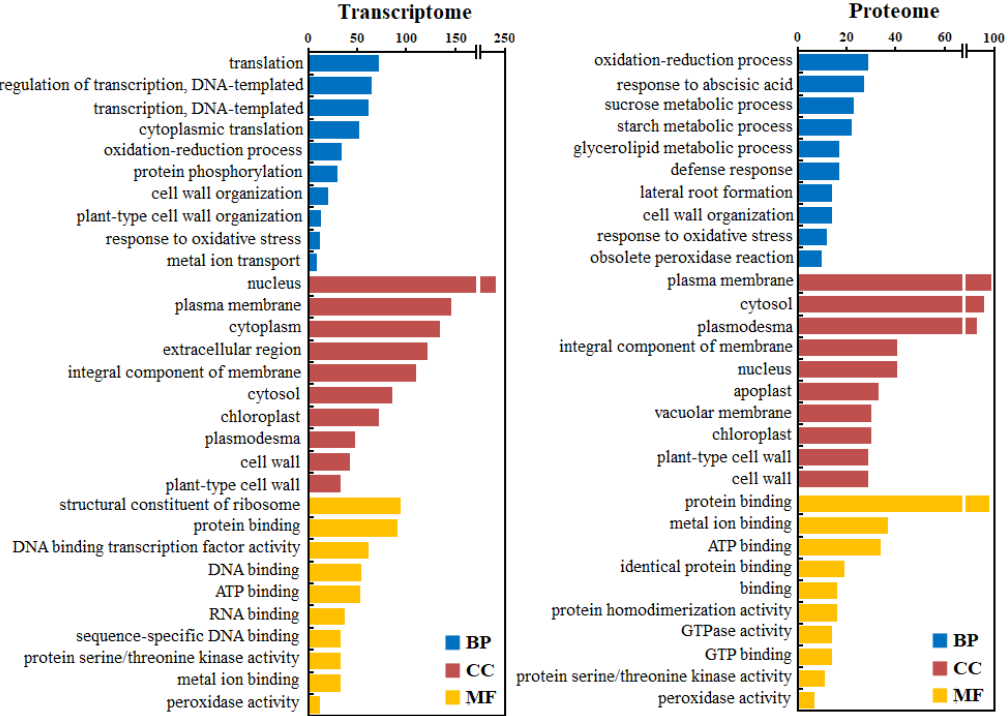
Figure 3. GO analyses of the differentially expressed genes and proteins. BP: Biological process; MF: Molecular function; CC: Cellular component.